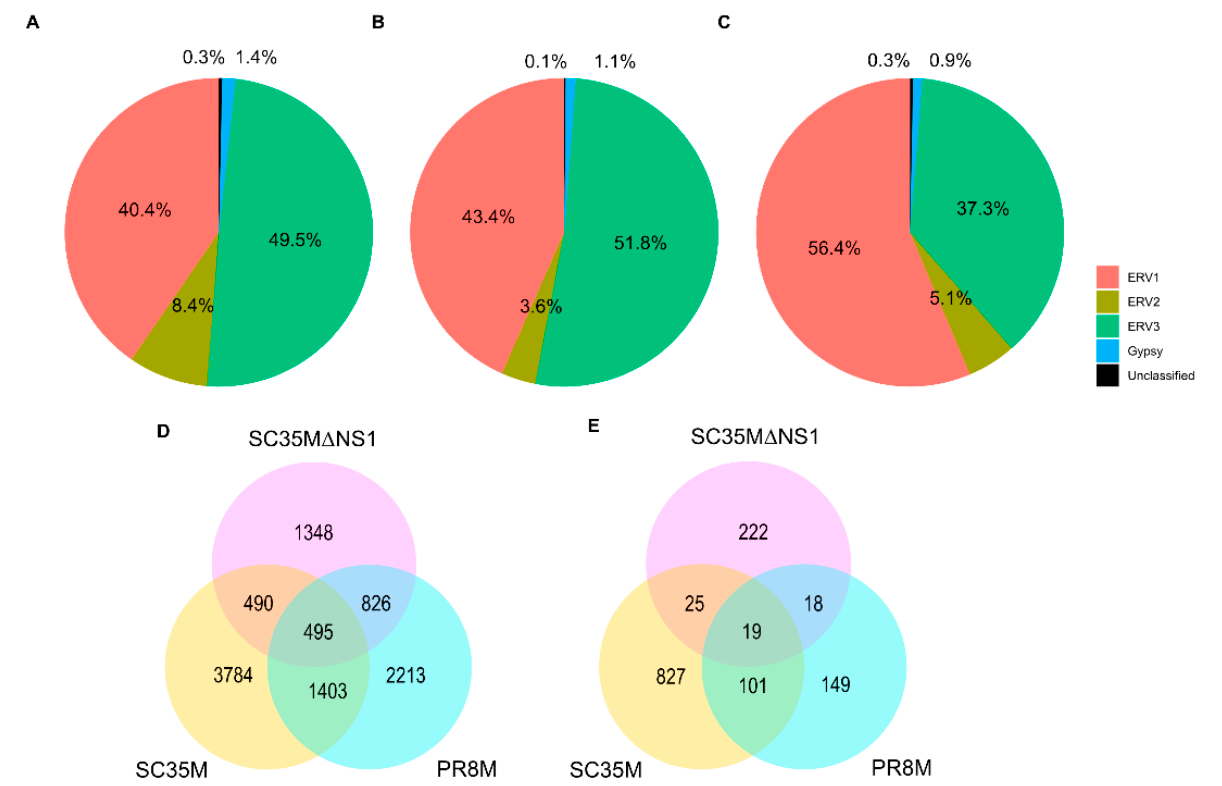
Figure 3. ( A – C ) Percentage of DEHERVs in each HERV superfamily in the cells infected by PR8M ( A ), SC35M ( B ), and SC35M ∆ NS1 ( C ). ( D , E ) Venn diagrams showing the overlap between the differentially expressed genes ( D ) and HERV loci ( E ) in the three infected cells (SC35M, SC35M ∆ NS1, and PR8M) relative to mock control.